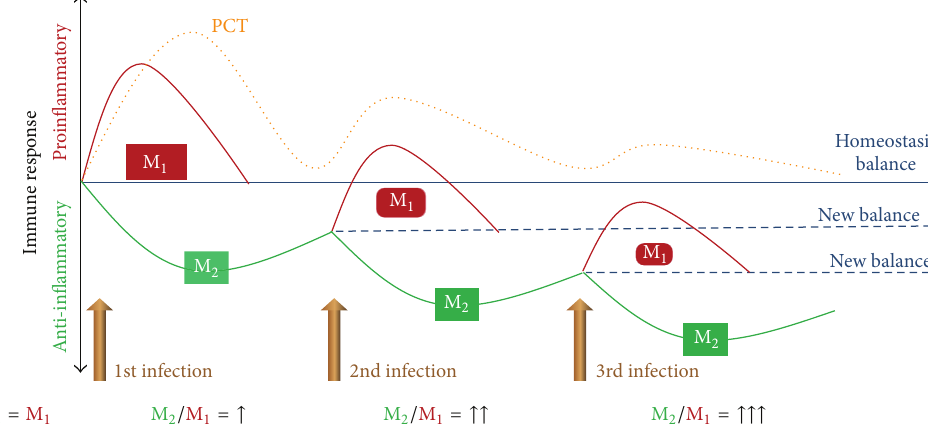
Figure 3: Procalcitonin response to consequent infectious insults. During regulated inflammatory response the two phenotypes of macrophages, (M) the proinflammatory (M 1 ) and anti-inflammatory (M 2 ), are balanced. As time goes by due to a dysregulated response patients become immunoparalyzed; in other words, M 2 overwhelms M 1 ; hence, forces are shifted towards “new balance.” This is reflected by lower PCT peak levels after each new infectious insult, which can be of the same gravity clinically. For further explanation see